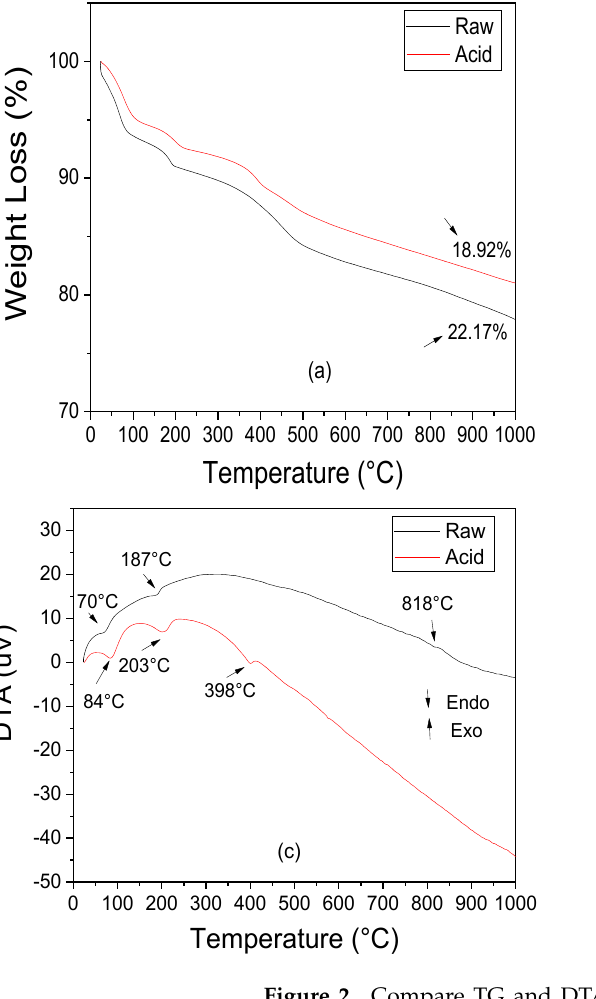
Figure 2. Compare TG and DTA curves of raw sample with the ( a , c ) acid functionalized, and ( b , d ) organo-functionalized samples.